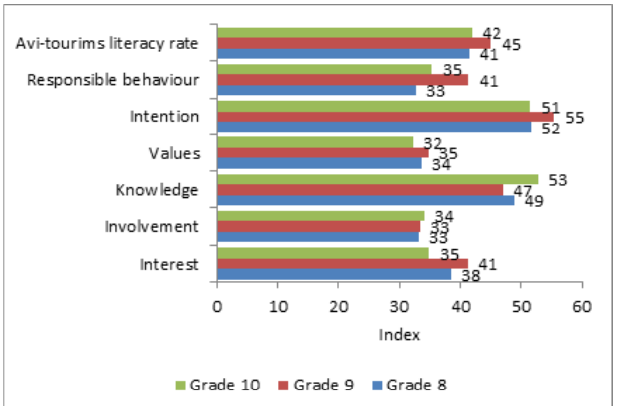
Figure 3: Avi-tourism literacy rates by school grade Correlations between